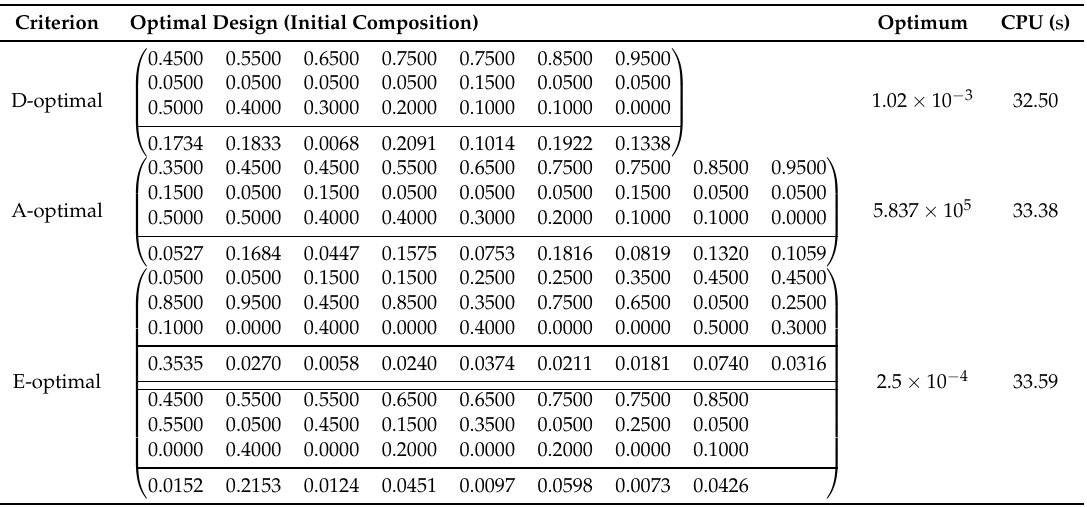
Table 5. Optimal designs for ternary system WAT-TOL-ANL and θ including nine parameters (initial mixtures).